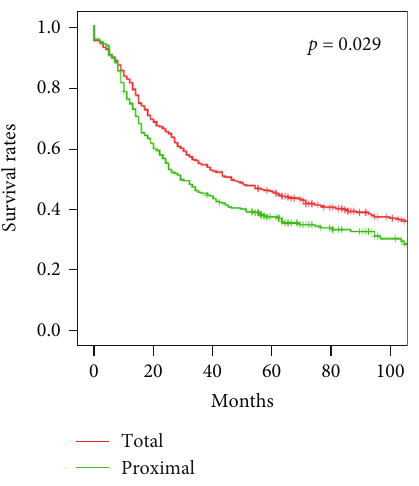
Figure 5: Survival of upper gastric cancer patients treated by total or proximal gastrectomy, p = 0 : 029